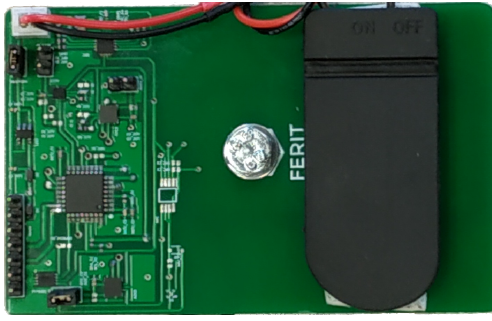
Figure 1. The Smart Sticker